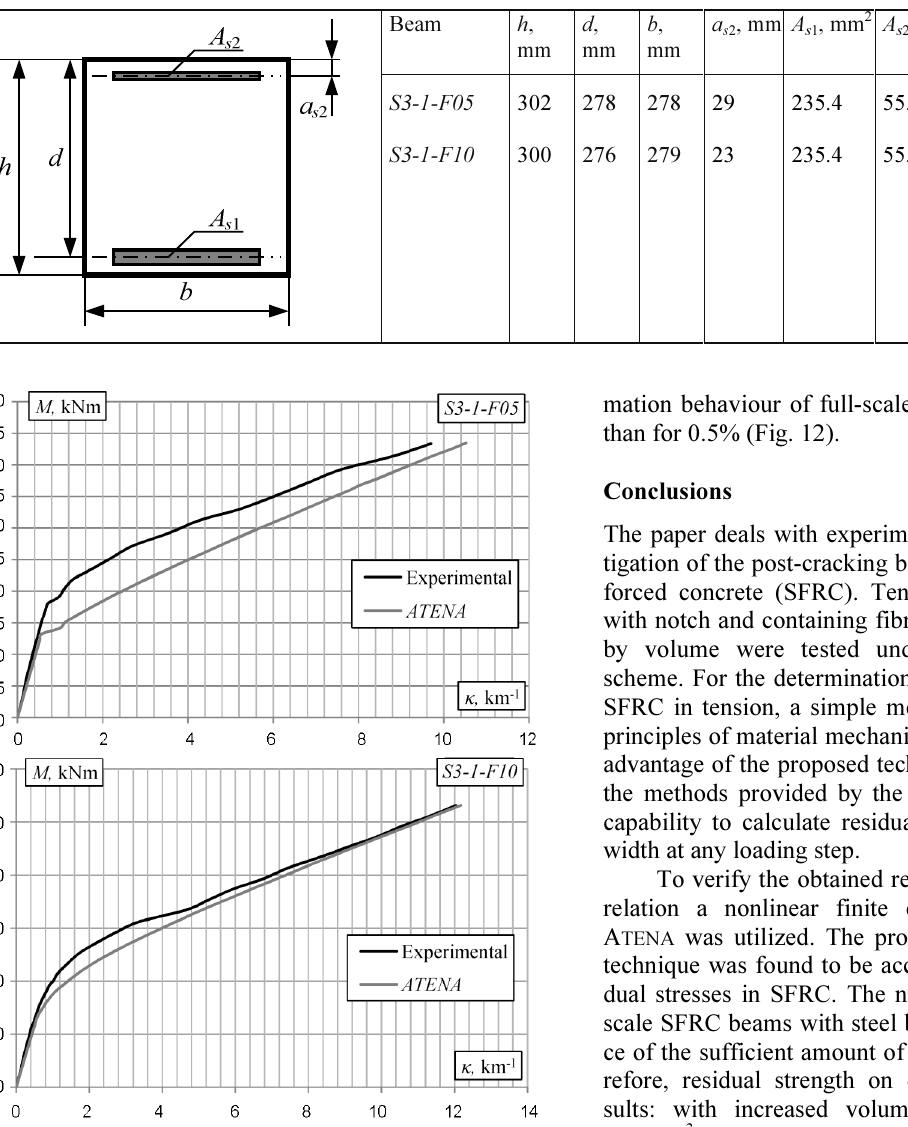
Table 1. Geometric and material parameters of the full-scale beams